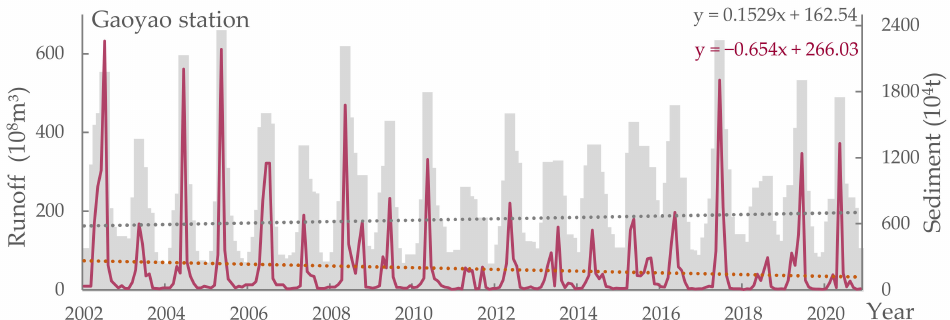
Figure 13. Runoff and sediment load at Gaoyao hydrological station, the outlet of the West River.